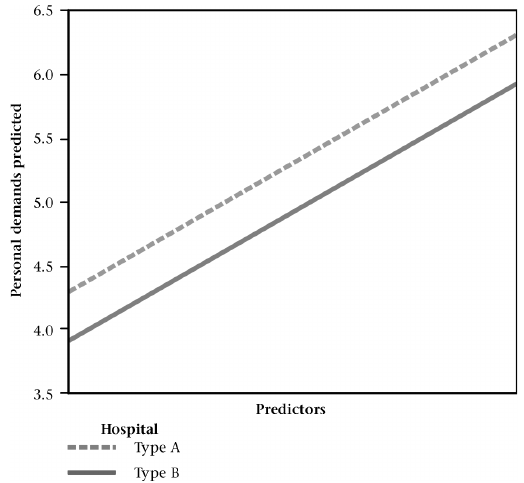
Figure 4: Predictors of Imposed Personal Demands